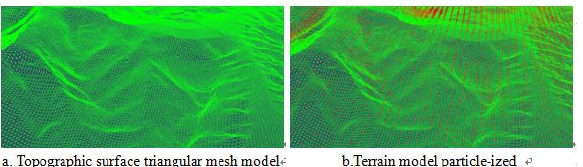
Fig.5 The surface particle-ization